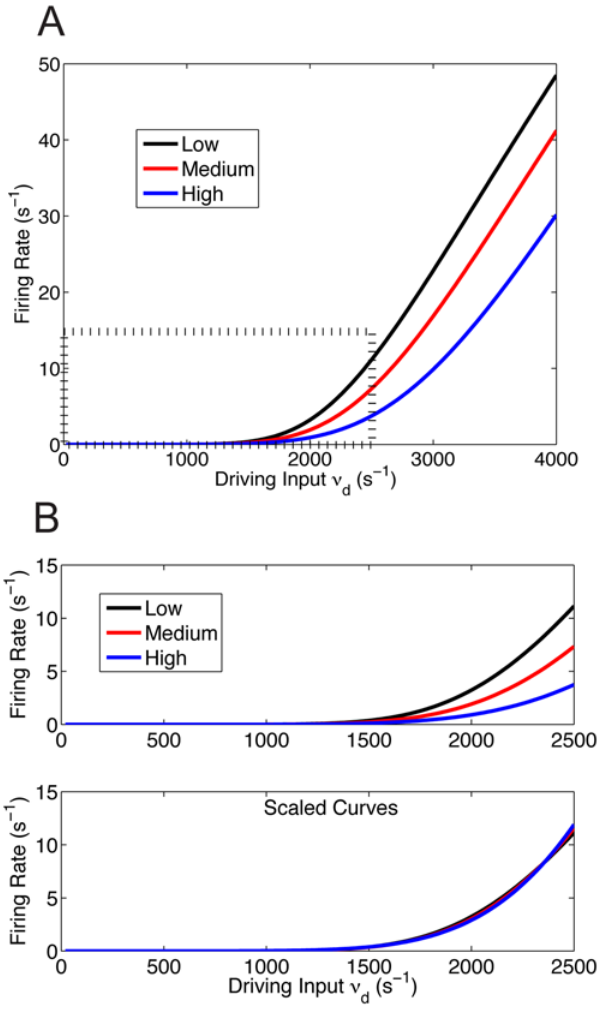
is e (see Equation j ~ 1 : 72 and r eq . Here, c eq j j 2